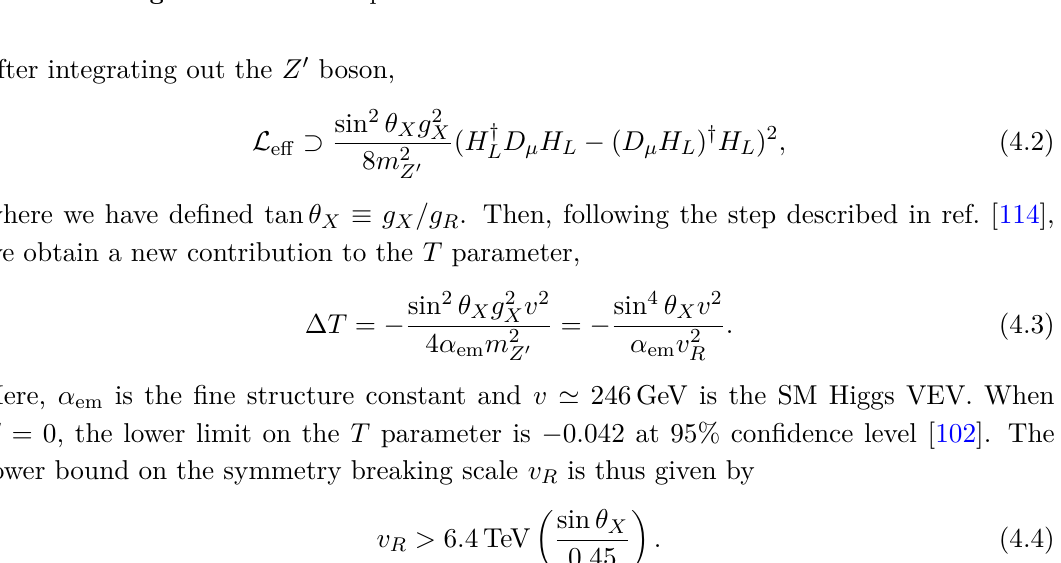
Figure 8 . A three-loop contribution to the electron EDM in our